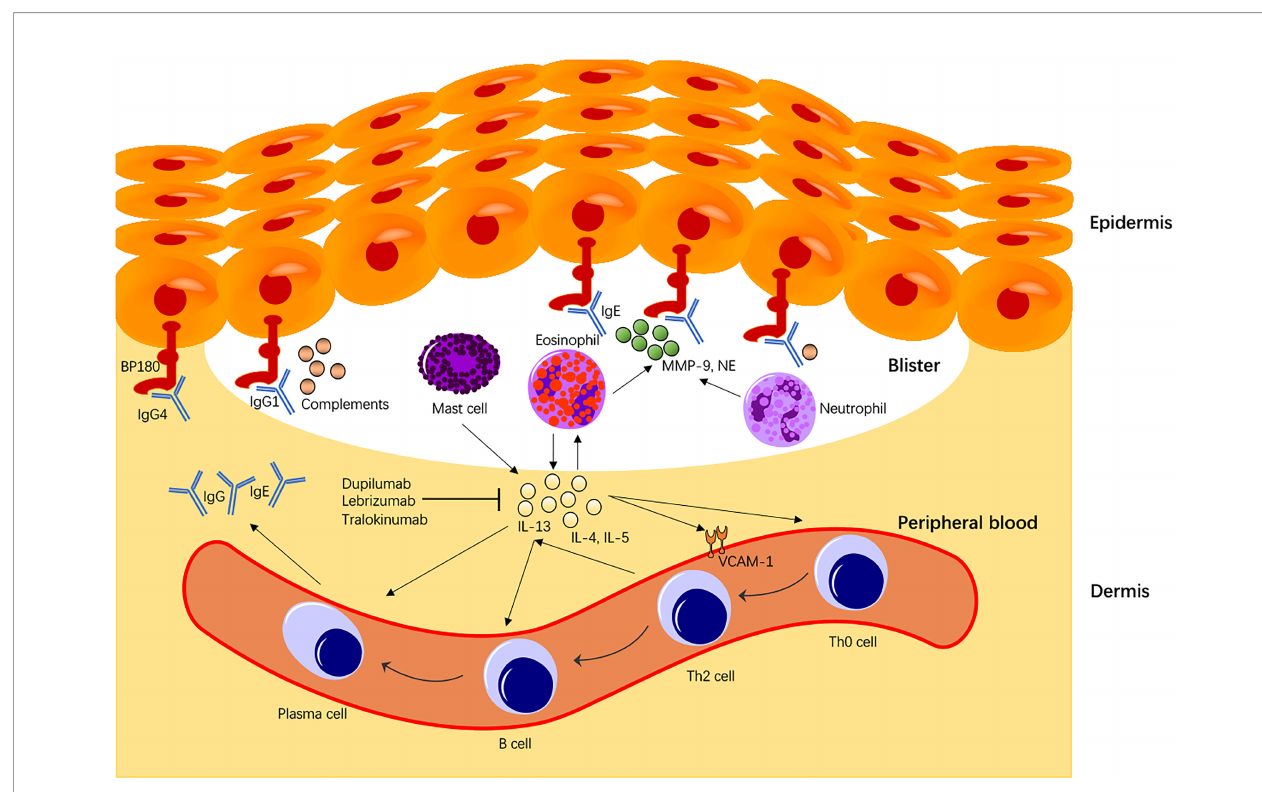
FIGURE 2 | Immunological roles of IL-13 in BP pathogenesis. IL-13 secreted from Th2 cells, or mast cells activates eosinophils that produce more IL-13 molecules in a “ positive feedback ” pattern. IL-13 also mediates the transition of Th0 to Th2 cells, the primary cells expressing IL-13. Moreover, IL-13 promotes activated B cell maturation to plasma cells expressing BP IgE autoantibodies and enhances BP immunoglobulins (Igs) class switching. IL-13 also enhances VCAM-1 expression that promotes transmigration of eosinophils and basophils to the dermis. In BP, IL-13 also promotes B cell maturation and directly stimulates plasma cells to secrete BP autoantibodies that play a central role in the BP disease pathomechanism. Secretion of proteolytic enzymes including NE and Metalloproteinase-9 from eosinophils or neutrophils causes degradation of BP180 molecules, contributing to the BP disease